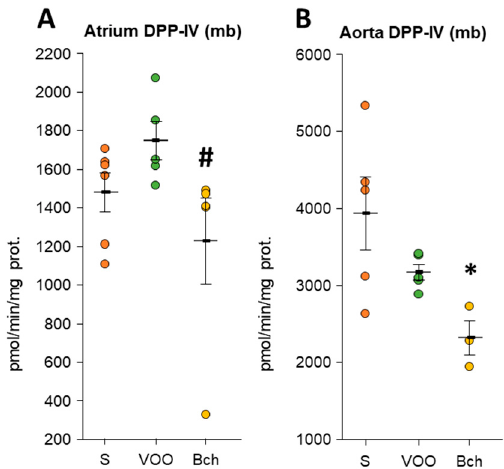
Figure 3. Mean values ± standard errors of significant ( A , B ) dipeptidyl peptidase IV (DPP-IV) activity in membrane-bound (mb) fraction of atrium and aorta. The small colored dots are data points per group. Values are expressed as pmol/min/mg prot in the rest of the tissues analyzed. * indicates significant differences between virgin olive oil diet (VOO) or butter plus cholesterol diet (Bch) vs. standard diet (S). * p < 0.05. # indicates significant differences between VOO and Bch, # p < 0.05.